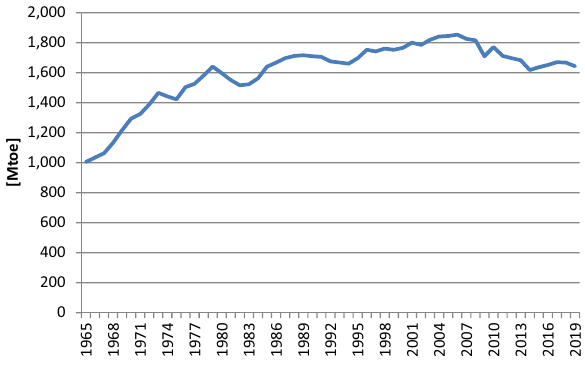
Figure 3: Primary energy consumption in the countries belonging to the European Union in the years 1965 – 2019. Source: own work based on ref. [ 2 ] . Note: excludes Estonia, Latvia, and Lithuania prior to 1985 and Slovenia prior to 1990.